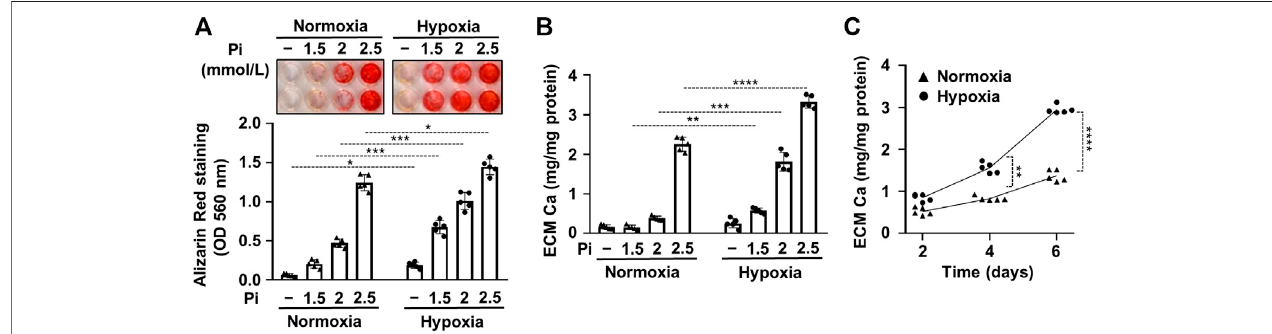
FIGURE 1 | Hypoxia increases Pi-mediated extracellular matrix calci fi cation of VSMCs. Con fl uent VSMCs were exposed to a calci fi cation medium containing Pi (1.5 – 2.5 mmol/L) under normoxic (21% O 2 ) and hypoxic conditions (1% O 2 ). (A) Ca deposition in the ECM (day 6) evaluated by AR staining. Representative image and quanti fi cation are depicted. (B) Ca content of the HCl-solubilized ECM. (C) Time course of Ca accumulation under normoxic and hypoxic conditions in the presence of 2.5 mmol/LPi. (A – C) Dataareexpressedasmean±SD, n =5. (A,B) Ordinaryone-wayANOVAfollowedbyTukey ’ smultiplecomparisonstestwereusedtoobtain